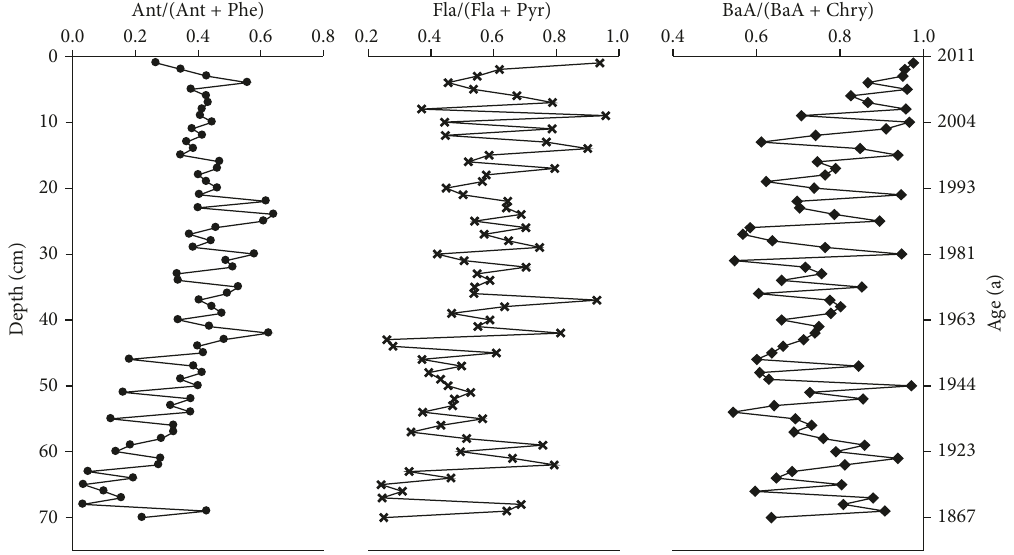
Figure 5: Ant/(Phe + Ant), Fla/(Fla + Pyr), and BaA/(BaA + Chry) ratios in the sediment. Table 1: Comparisons of PAHs in different sediments in China. Sampling